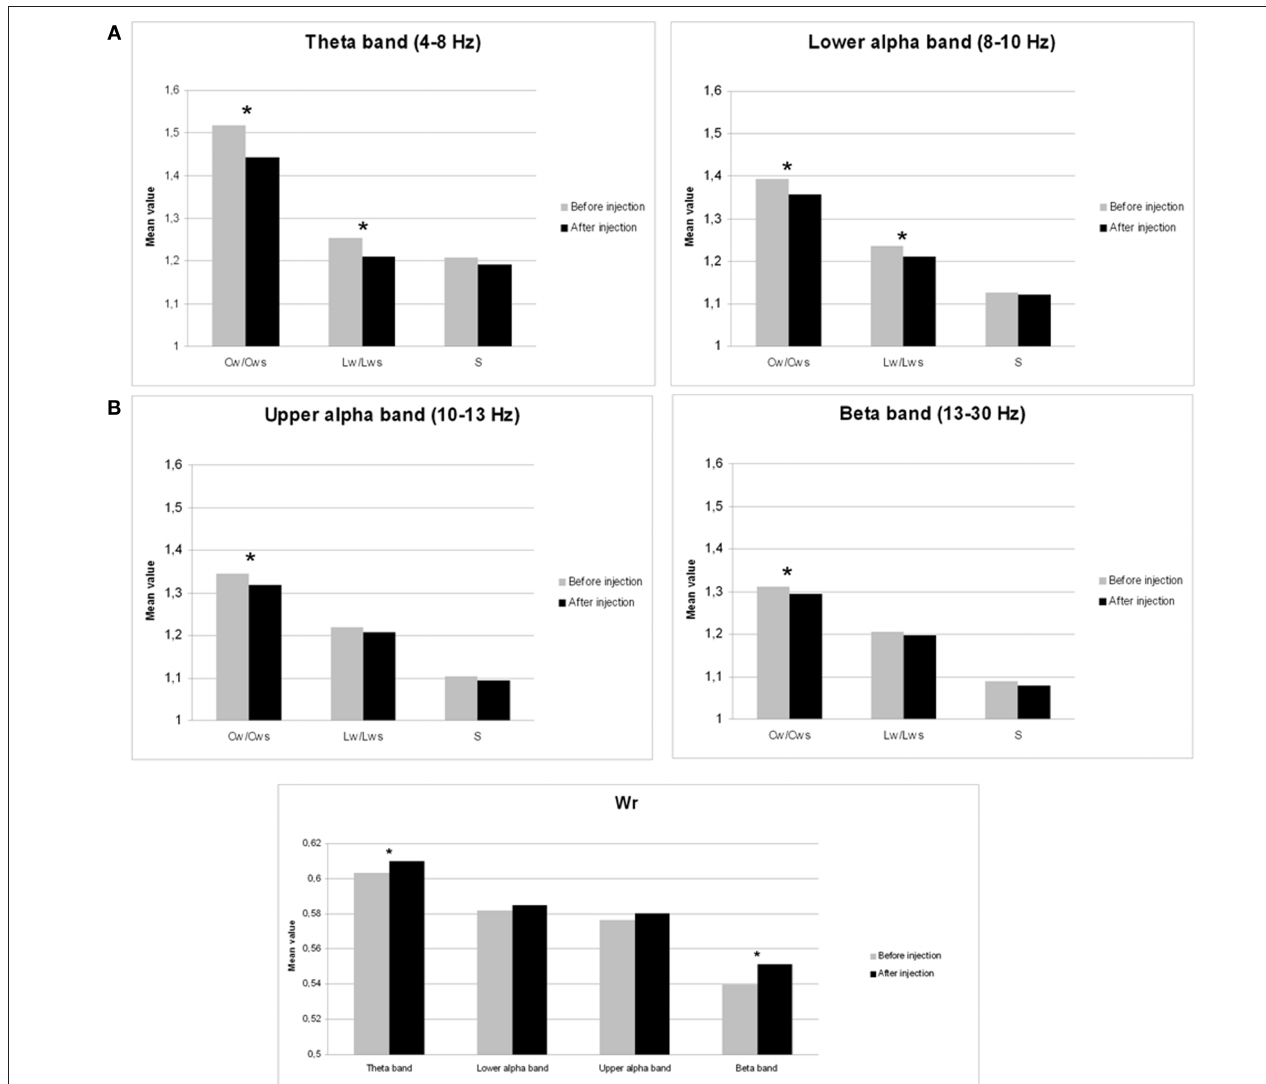
FigUre 1 | Mean changes in network features after injection of sodium amobarbital . * p < 0.05 (corrected for multiple comparisons). (a) C clustering coefficient, L